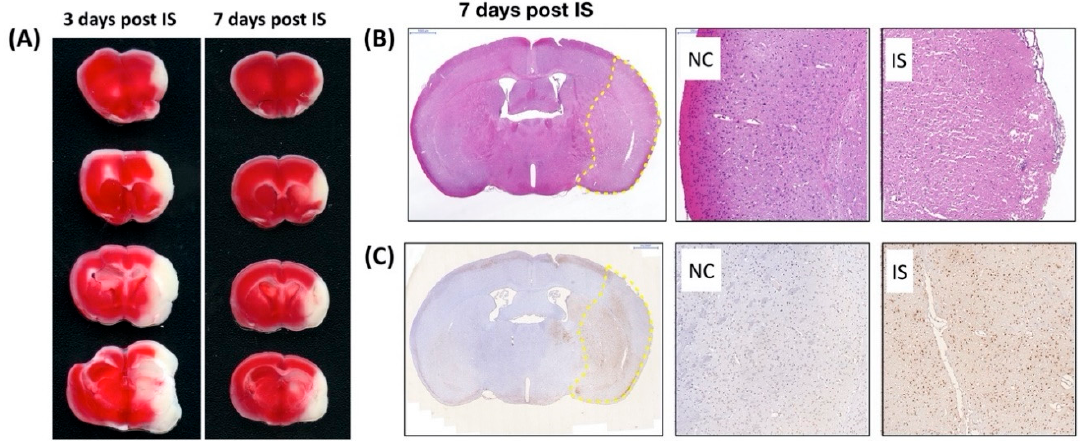
Figure 4. Characterization of cerebral ischemia stroke in mouse. 2,3,5-triphenyltetrazolium chloride (TTC) staining, hematoxylin and eosin (H&E) staining, and terminal deoxynucleotidyl transferase (TdT) dUTP nick-end labeling (TUNEL) assay were used to identify the brain infarcted region in mice with middle cerebral artery occlusion (MCAO). ( A ) The white color shown in the TTC staining indicates the loss of dehydrogenase activity in the infarcted region. ( B ) Seven days post ischemic stroke, to identify the cerebral infarction in high power field, the histopathological examination was performed on cerebral paraffin sections with H&E staining. The infarcted region is indicated by the yellow dashed line surrounding. ( C ) Seven days post ischemic stroke, to validate the apoptosis or necrosis in the infarcted or peri-ischemic region, TUNEL assay was performed on cerebral paraffin section. The dramatically increased apoptotic nuclei (with DNA fragmentation, brown color) were observed in the cerebral striatum and cortex with ischemic stroke. IS, ischemic stroke.